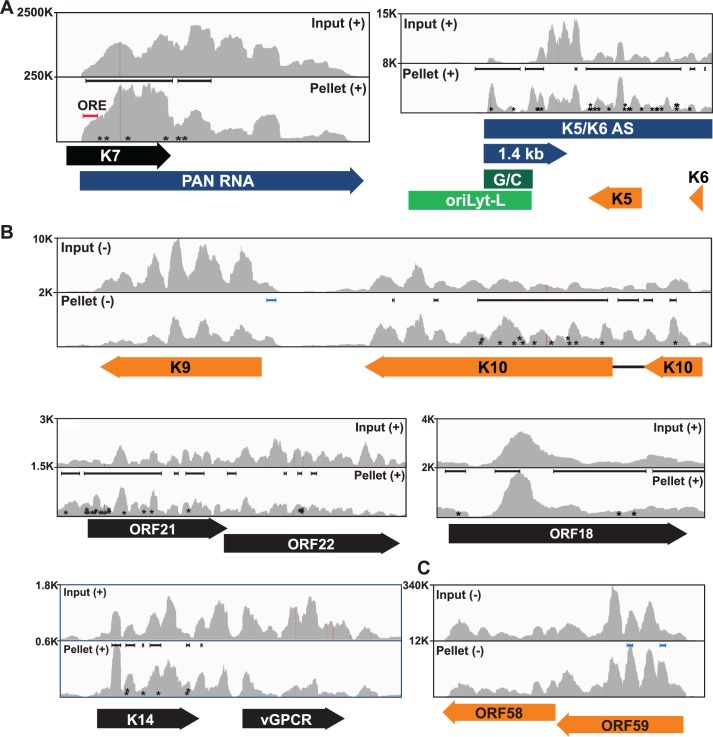
Sequence reads across various viral genomic loci.Mapped sequence reads of input (top) and pellet (bottom) from one biological replicate for the region surrounding (A) PAN RNA (left) and oriLyt-L (right). (B) Additional loci in which enriched clusters were observed in the high stringency dataset. (C) ORF58-ORF59 region, which was only identified in the low stringency dataset. In all panels, reads from only one strand are shown which is indicated by the plus or minus signs. The black bars above the peaks in the pellet panels mark the positions of the enriched clusters from the high stringency dataset whereas the blue bars were observed only in the low stringency dataset. The color schemes for genes are the same as Fig. 2. The numbers at the top left of each frame are proportional to the number of reads stacked in a given window. The asterisks approximate the positions of T→C or deletion mutations observed in the pellets.